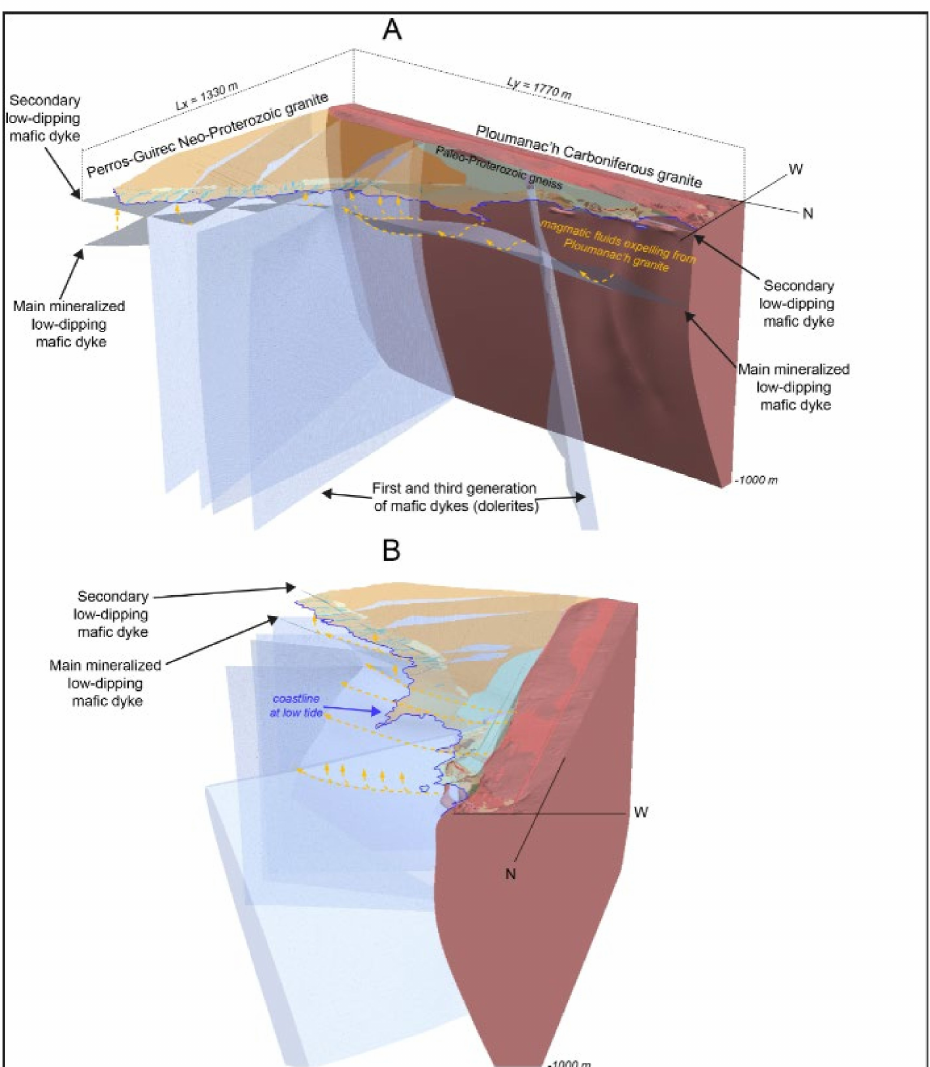
Figure 10. Two views (A from NE and B from NNW) of the3D geometrical model of the study area (1330 m × 1770 m × 1000 m), focused on the dykes channeling the mineralizing fluids (yellow arrows) as a result of Ploumanc’h granite cooling. 3D model created in Geomodeller© 4.0.7 software viewed and annoted in ESRI ArcScene© 10.5.1. For clarity, the Perros-Guirec granite and the Paleo-Proterozoic gneiss have been removed at depth from the 3D view but are still visible on the surface geology limited by the coastline at low tide (blue line). Also, only some of the main mafic dykes are represented. The main mineralized low-dipping mafic dyke does not crop, its geometry derives from the magnetic modelling. The secondary more superficial low-dipping mafic dyke, outcrops along the coast, it dips westwards rather constantly at 35 ◦ , with an orientation slightly rotating between N130 ◦ E and N170 ◦ E from south to north. The detailed 3D modelling of both low-dipping dykes, taking into account field measurement and the magnetic model geometry at depth, clearly shows that both structures are subparallel. Therefore, the slightly mineralized low-dipping mafic dyke outcropping along the beach, emplaced in a low-angle reverse fault, is a nice accessible replica of the main mineralized structure at